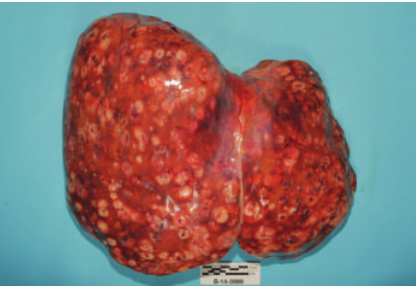
Figure 3: Liver weighed 4950 grams and that is enlarged with intact smooth capsule with soft tan brown parenchyma which was nearly completely replaced by multiple discrete tumor masses.